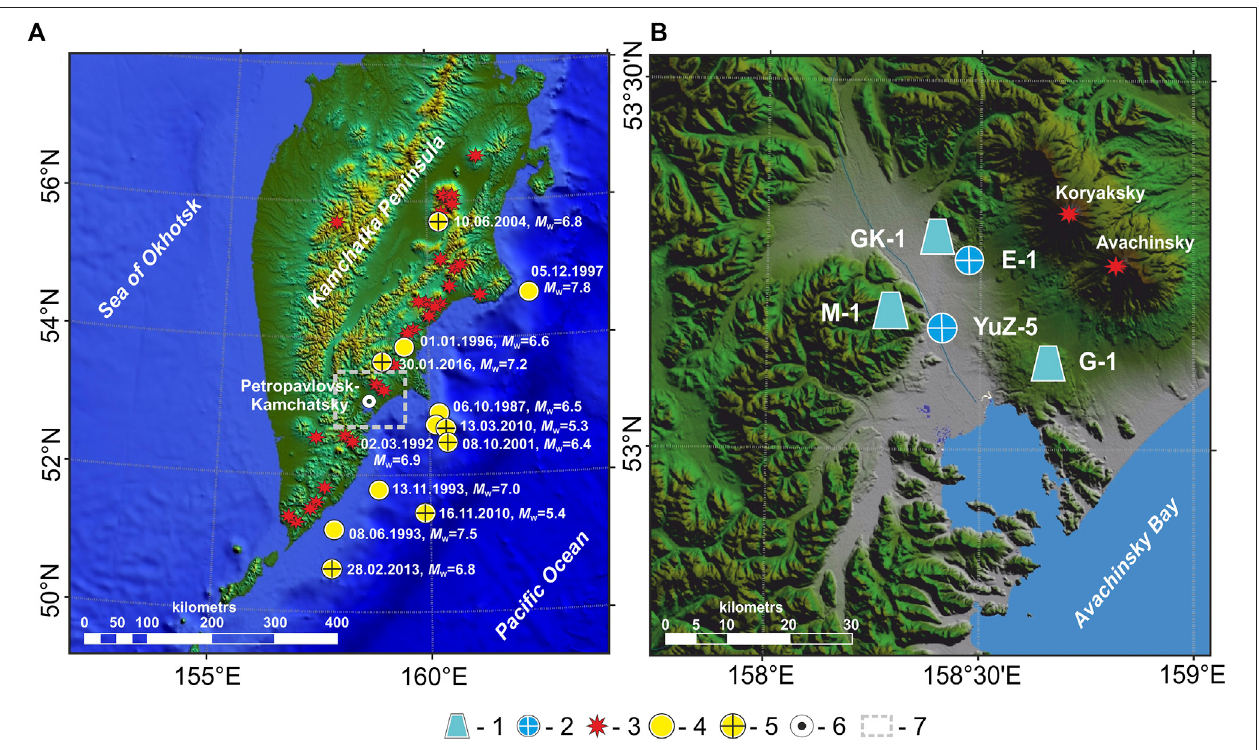
FIGURE1| Thelayoutoftheobservation wells andearthquakeepicentersinthe Kamchatka Peninsula: (A) earthquakesprecededbyhydrogeologicalprecursors; (B) observation wellsatthePetropavlovsk-Kamchatskytestsite. Designations:1, fl owingwells; 2,piezometricwells;3,activevolcanoes;4,5,earthquakeepicenters:4, hydrogeological precursors revealed retrospectively; 5, hydrogeological precursors detected in water-level changes in the E-1 well in real time; 6, Petropavlovsk- Kamchatsky city; 7, Petropavlovsk-Kamchatsky test site in Figure 1A .